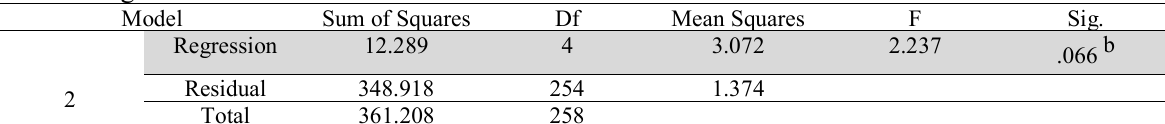
Model 2 regression – ANOVA a